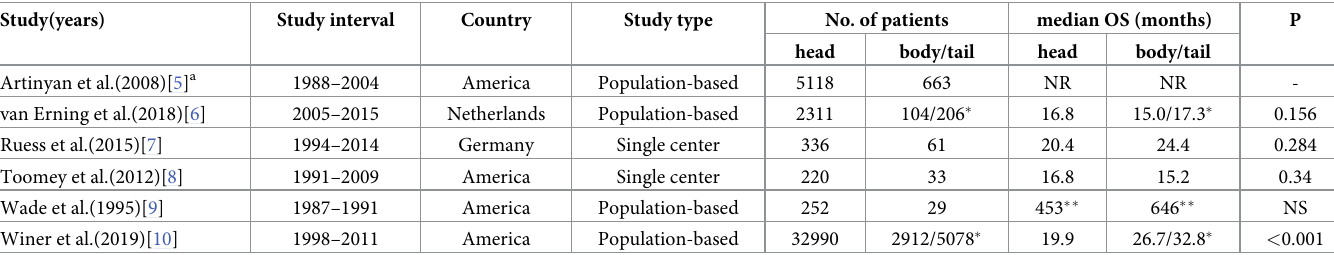
Table 1. Studies discussing the prognostic relevance of the tumor